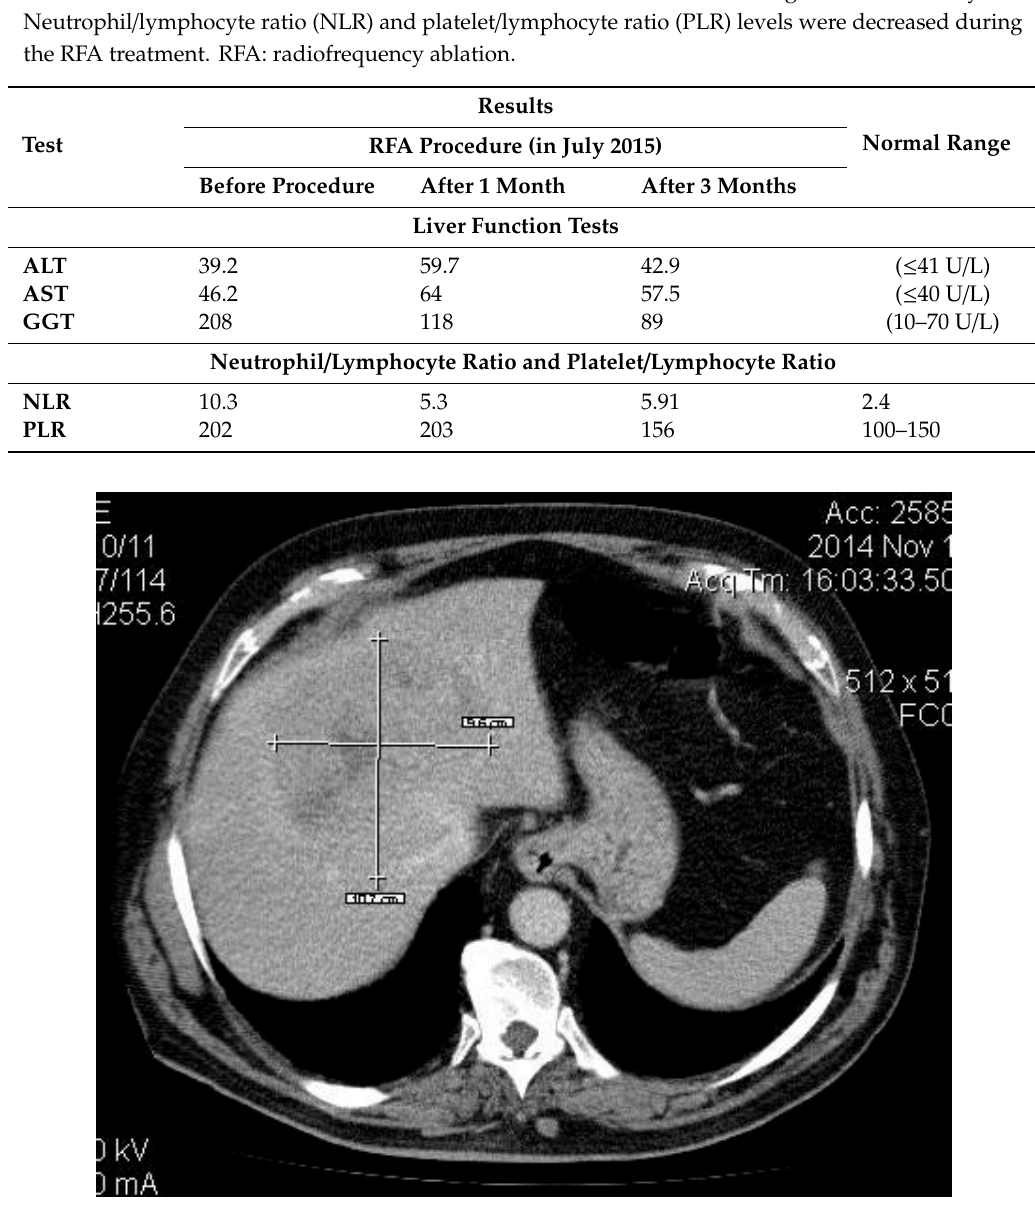
Figure 1. CT revealed a giant metastatic lesion located centrally, mainly in segment 4.